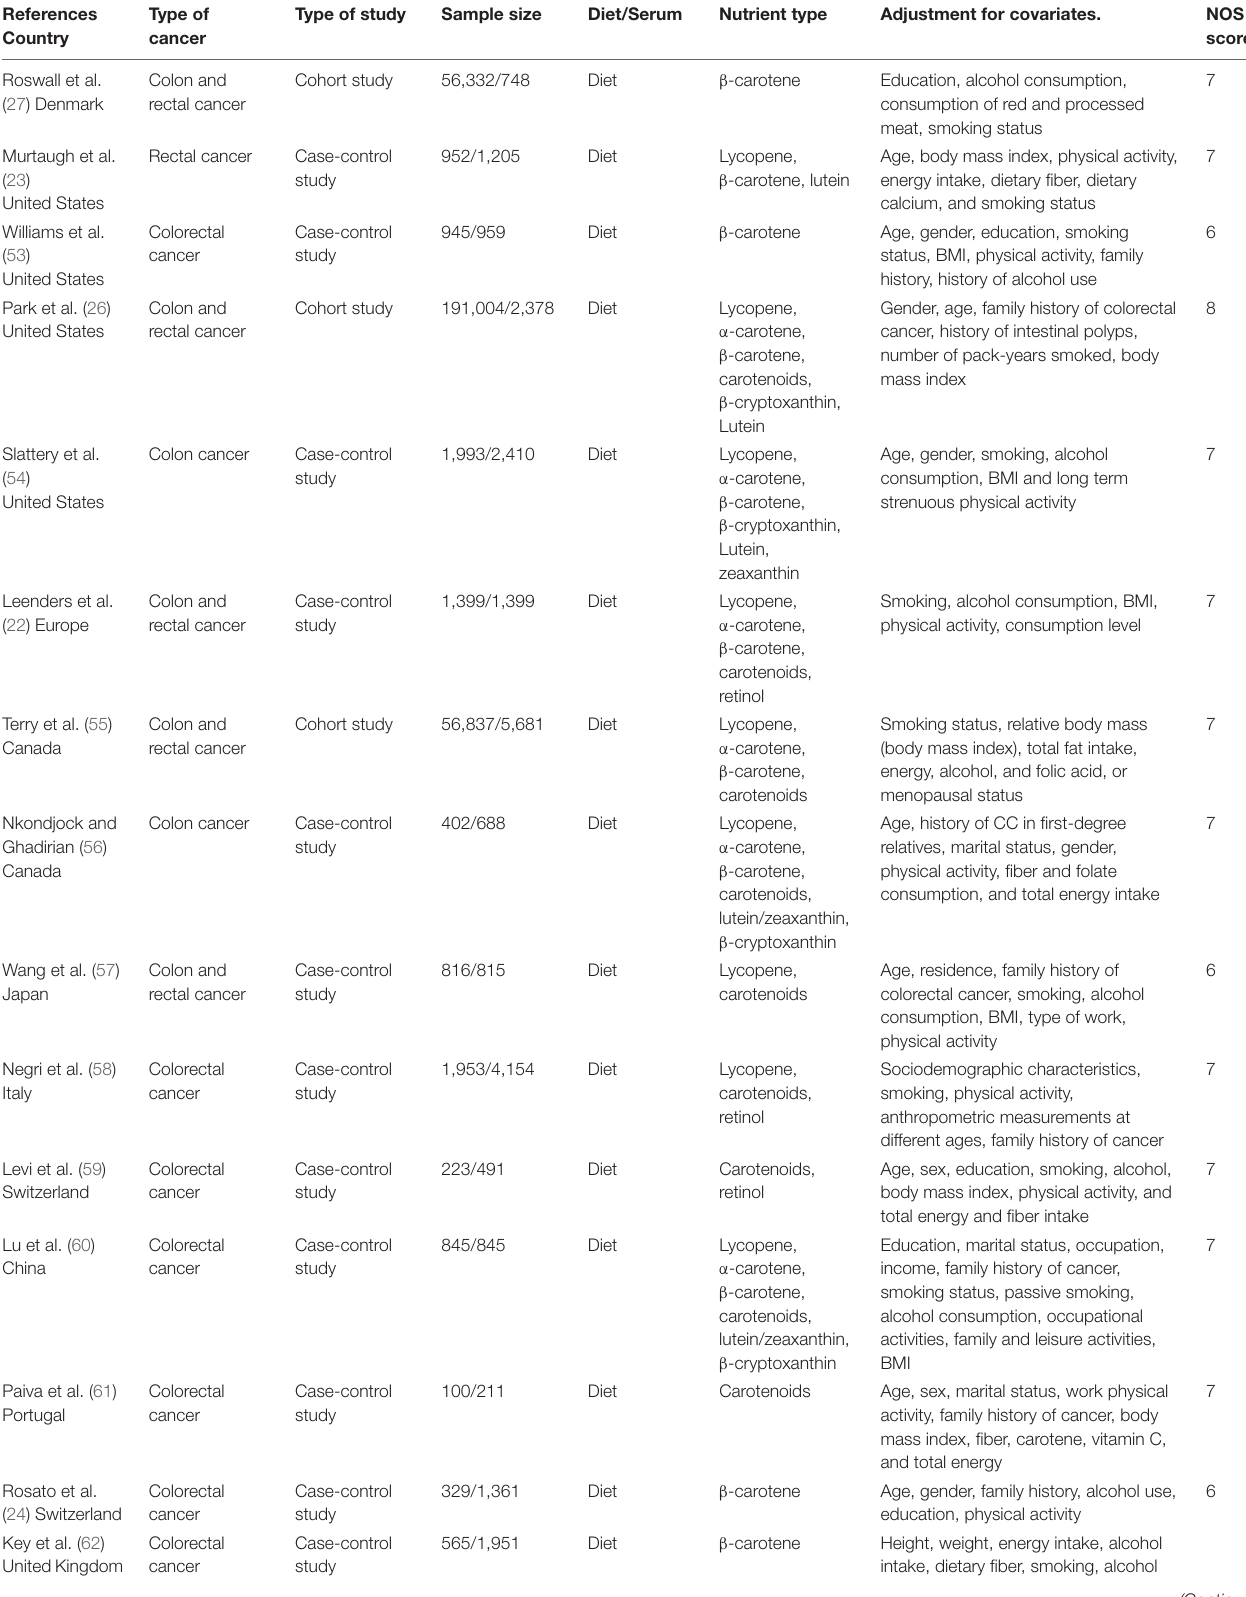
TABLE 1 | Characteristics of included